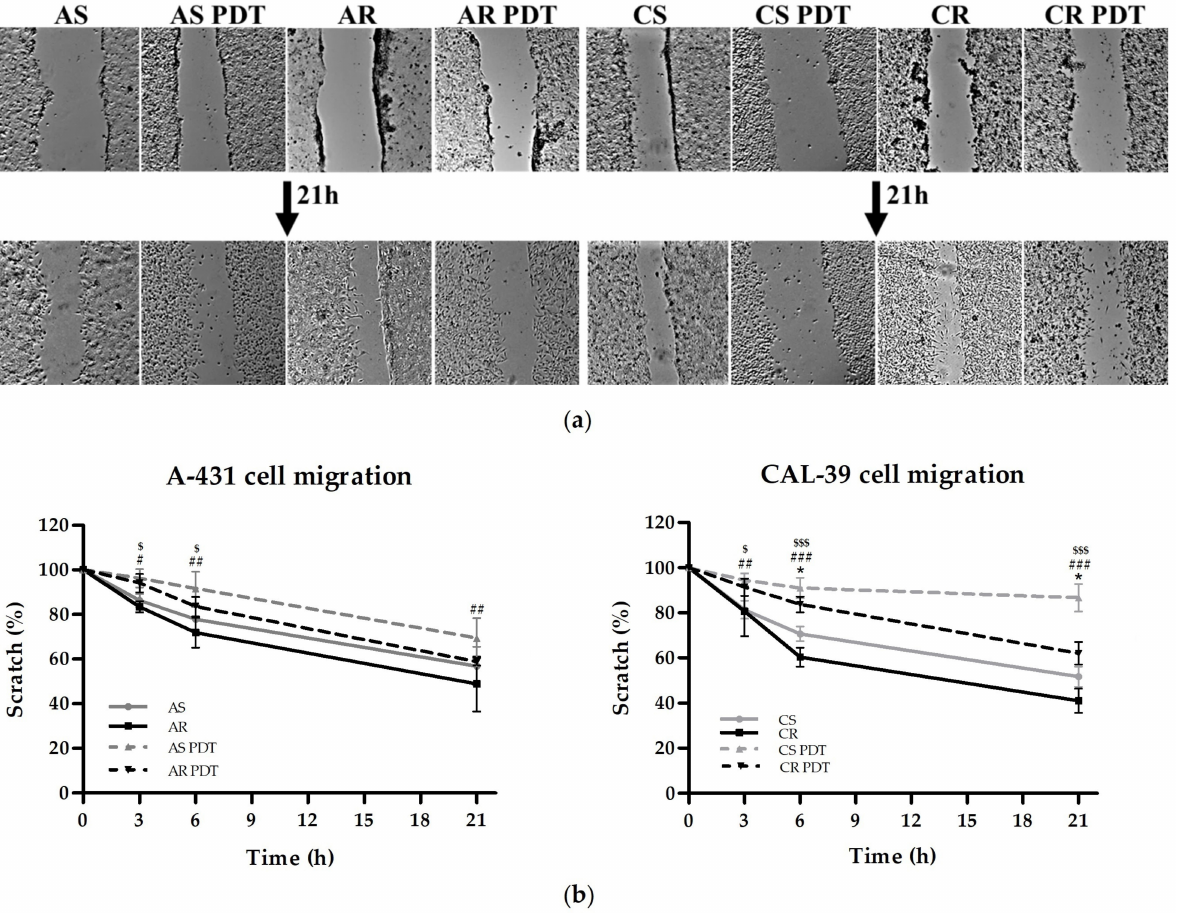
Figure 8. Assessment of migration rate. ( a ) Pictures of scratches at time 0 and after 21 h taken using an Olympus Xcellence fluorescence microscope with 4 × objective. ( b ) Graphs showing the mean percentage of the scratch size. Statistical significance between groups were calculated in two-way ANOVA with Bonferroni post-test (differences between sensitive and resistant cells: * p ≤ 0.05; between untreated and treated cells in sensitive lines: # p ≤ 0.05, ## p ≤ 0.01, ### p ≤ 0.001 and in resistant lines: $ p ≤ 0.05, $$$ p ≤